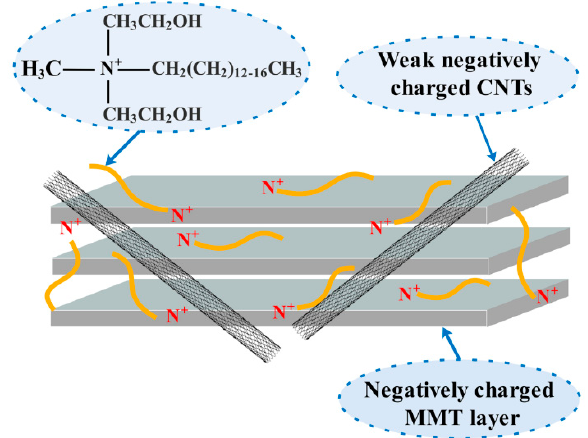
Figure 4. Schematic illustration of the interaction between CNTs and MMT.